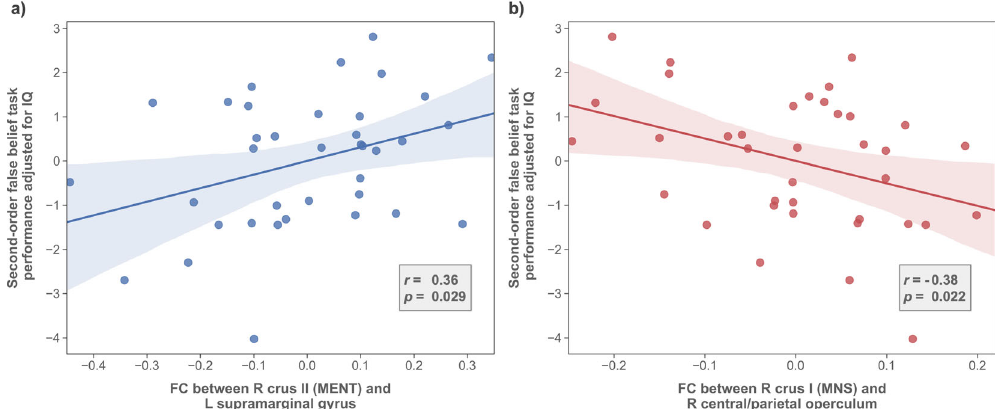
Fig. 2 Relationship between cerebello – parietal functional connectivity (FC) and ToM performance in patients with fi rst-episode psychosis (FEP). Scatter plots, regression lines, and their 95% con fi dence intervals for partial correlation analysis controlling for intelligence quotient (IQ) ( a ) between the right crus II and left SMG FC ( z scores) and second-order false belief scores and ( b ) between the right crus I and CO/PO FC and second-order false belief scores in FEP patients are displayed. R right, L left, FC functional connectivity, MENT mentalizing network, MNS mirror neuron